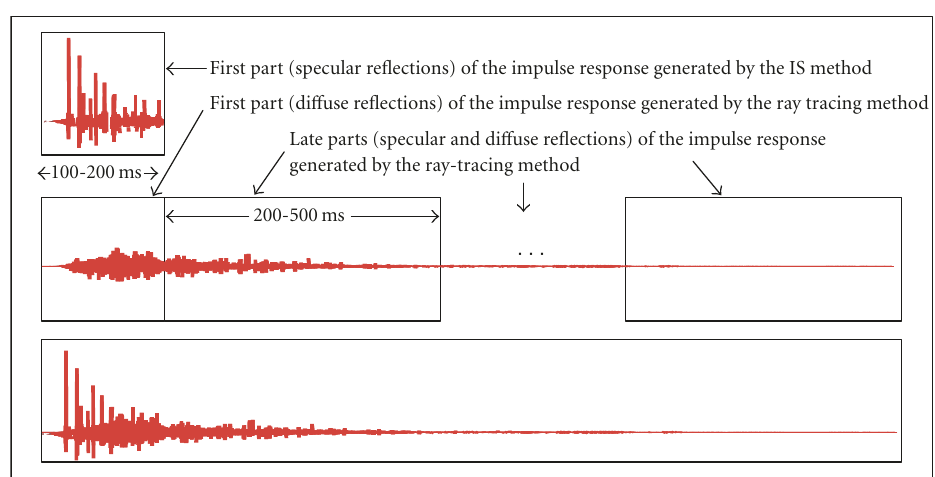
Figure 15: Combination of filter (or filter segments) for one ear generated by ray tracing and the first part of the impulse response generated by the image source model.